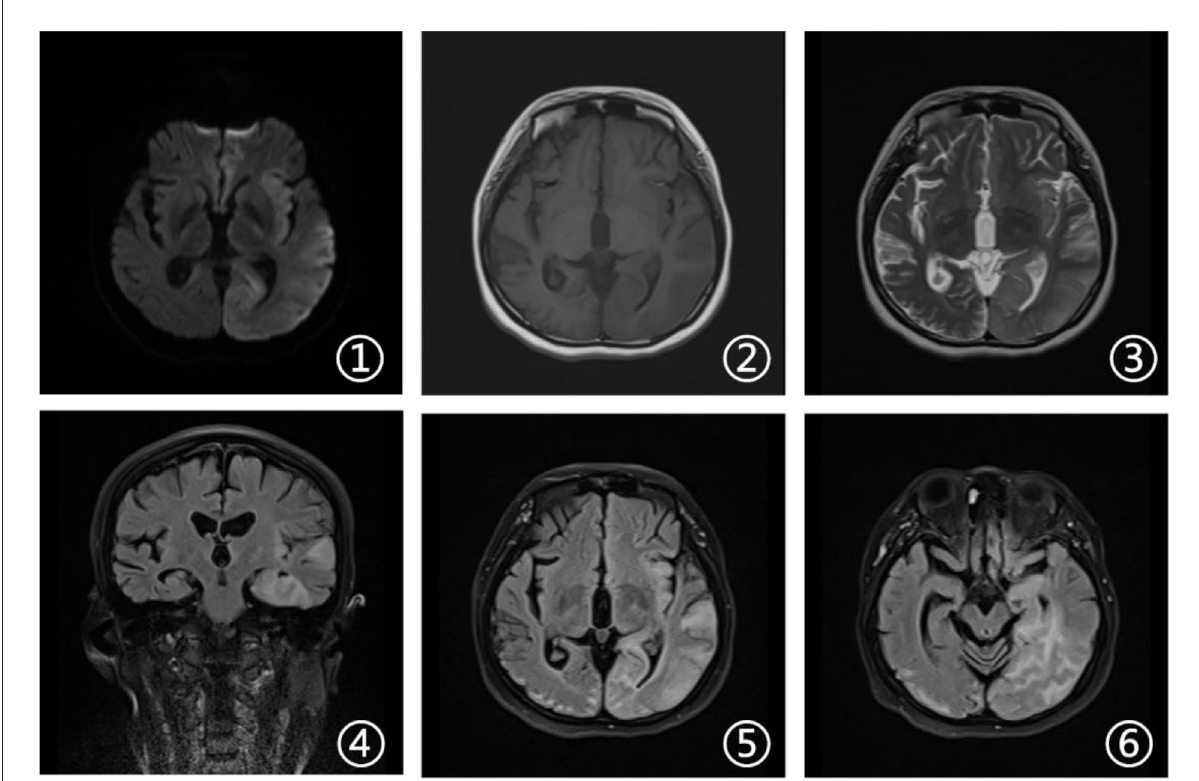
FIGURE5 Brain magnetic resonance imaging. Axial DWI, T2-weighted and FLAIR sequences (1, 3, 5, and 6) showed damage in the left cerebral hemisphere covering the frontal, temporal, and occipital lobes. Axial T1-weighted sequences (2) revealed hypointense signal in corresponding areas. Coronal FLAIR MRI (4) revealed high signal changes in the hippocampal area and the left temporal cortex.